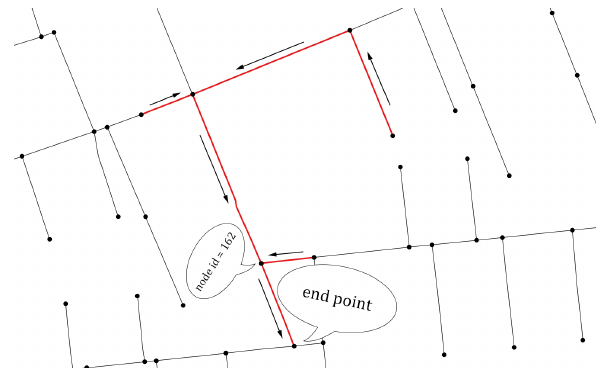
Figure 9. Network part that transports waste water using gravity. edge, the so-called source. The end node id column contains the identifier of the second end point vertex of the edge, the target. In addition, a ’cost’ column is required by pgRouting, which con- tains a value representing the weight of an edge. By default this column is not part of the UTN9 LINK table and can, therefore, either be added or defined “on the fly” at query execution